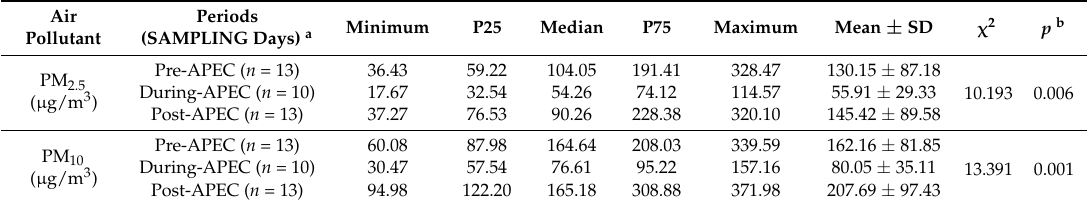
Table 1. Characteristics and comparison of particulate matter in various